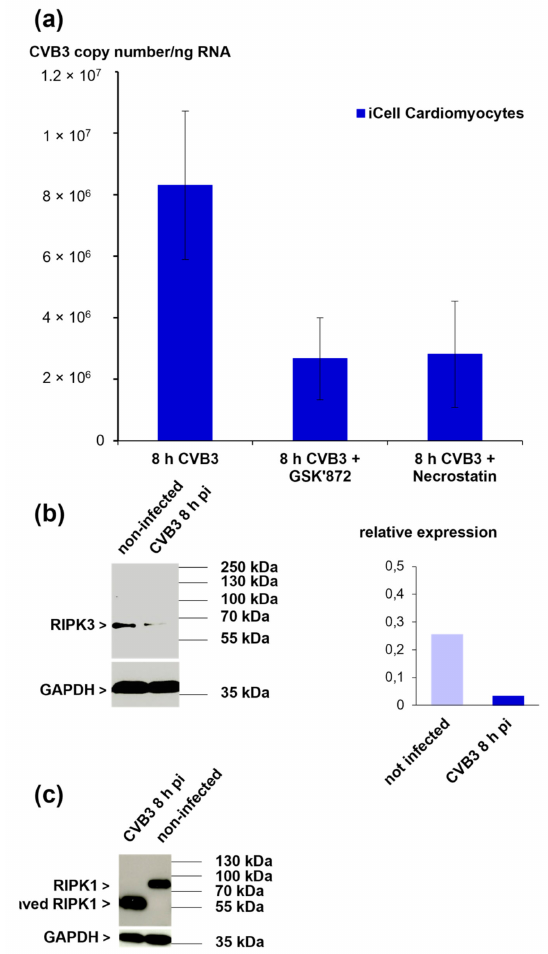
Figure 6. ( a ) Quantification of viral load in iCell ® Cardiomyocytes after inhibition of RIPK3 kinase activity (GSK’872) and inhibition of RIPK1 kinase activity (necrostatin). ( b ) Western blot analysis of RIPK3 expression in CVB3-infected iCell ® Cardiomyocytes eight hours pi (MOI 10) (left panel). Densitometric analysis is shown in the right panel. Data were normalized to GAPDH. ( c ) Western blot analysis of RPK1 expression in CVB3-infected iCell ® Cardiomyocytes eight hours pi (MOI 10). 3.8. The Viral Proteases 2Apro and 3Cpro Are Not Responsible for the Cleavage of RIPK1 in iCell ®